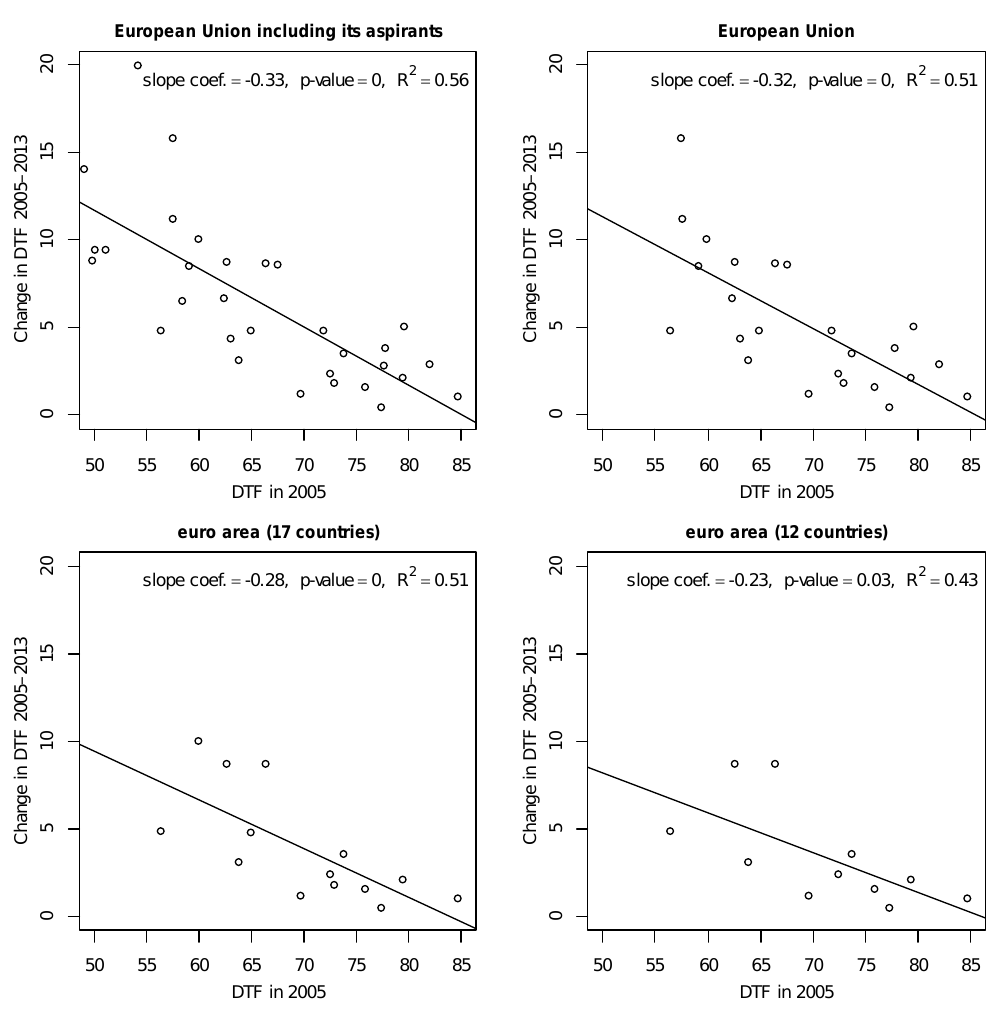
Figure 9 : β -convergence in business